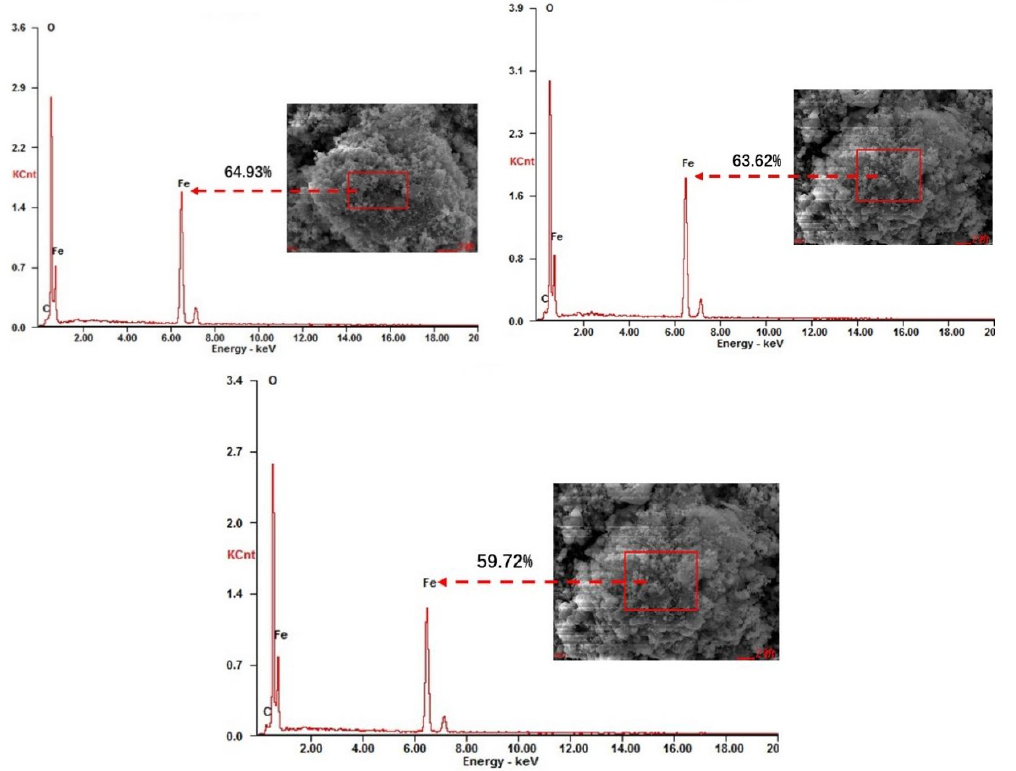
Figure 4. EDS spectra of Co-nZVI/GAC, and SEM images of different positions on the right.